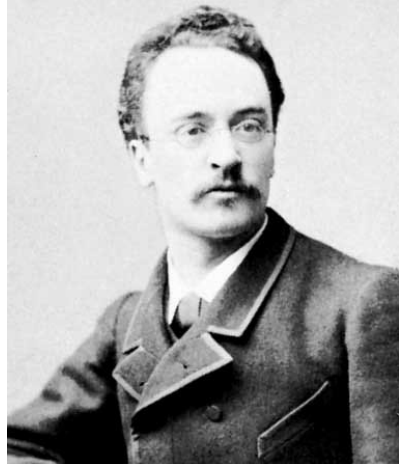
Figure 2. Early portrait of Rudolf